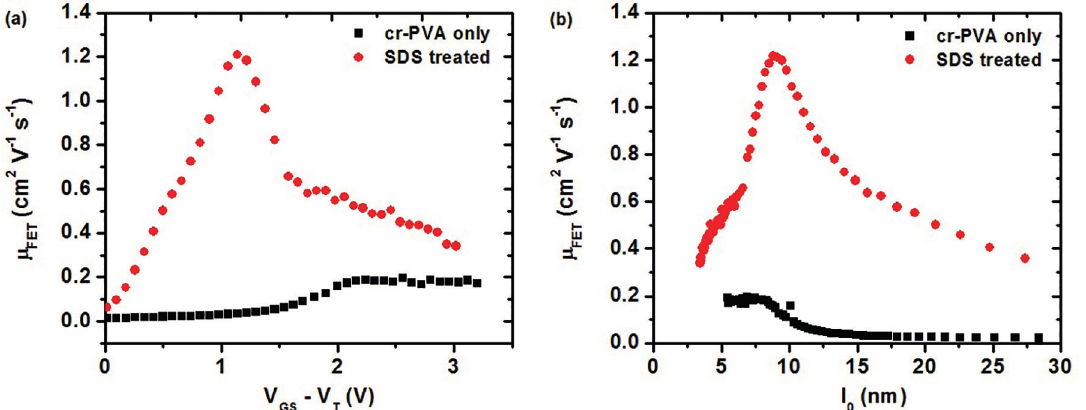
- V , (b) minimum effective channel bottleneck thickness ( l GS T = 5 DS